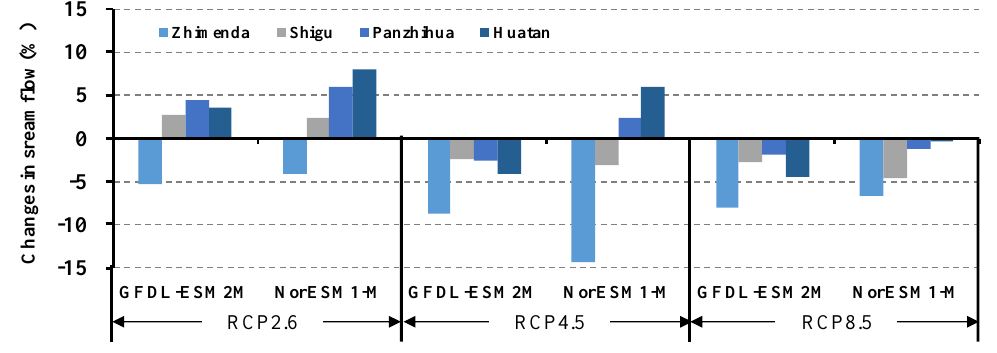
Figure 16. Changes in mean streamflow for 2021 to 2050 in different stations.